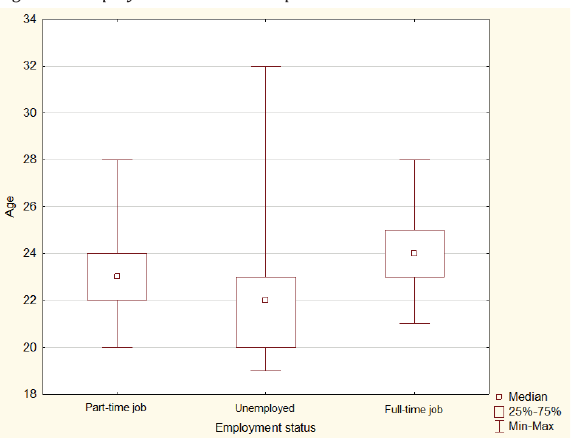
Figure 1. Employment status. Box-plot.